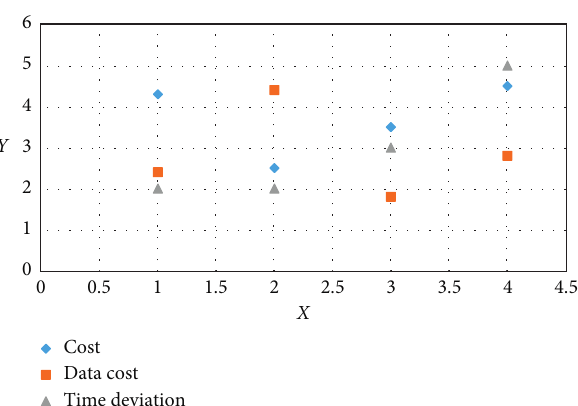
Figure 6: Demonstration chart of the standardized management enterprise supply chain level.